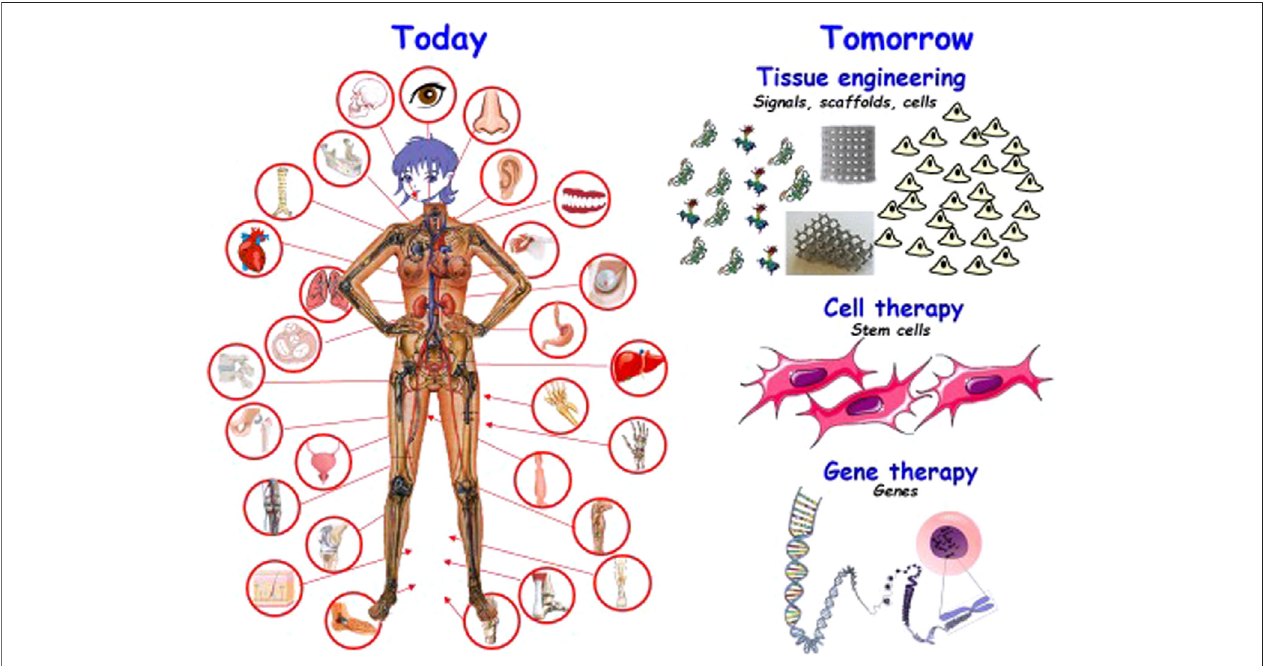
FIGURE 1 | Translation from the laboratory to the patient ’ s